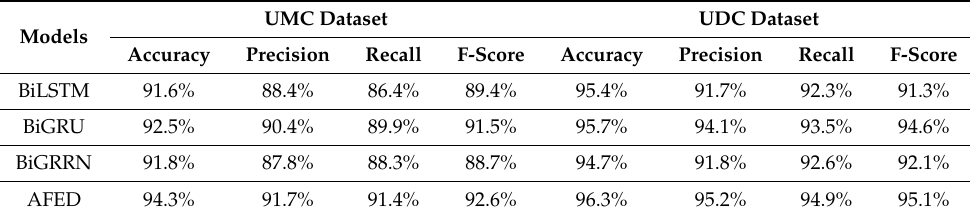
Table 5. Overall results of both datasets for all models over the given hyperparameters.